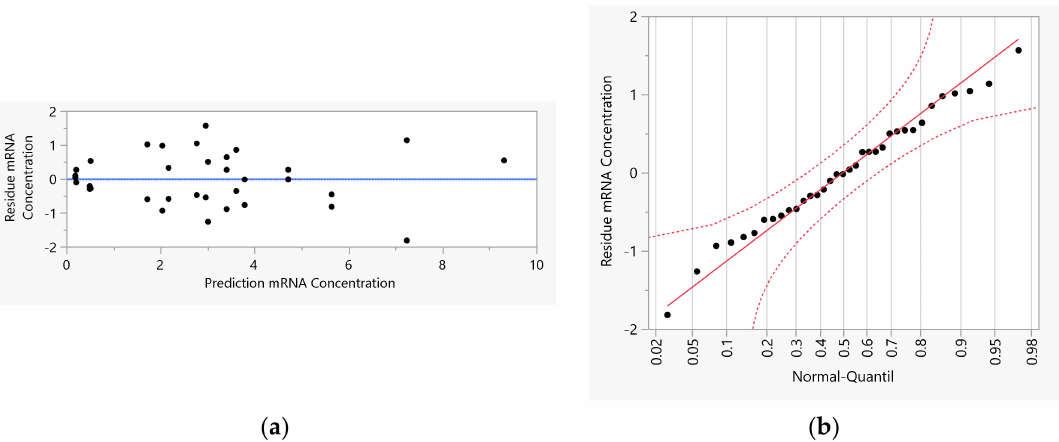
Figure 15. Visualization of the residuals (black dots) in an ( a ) ideal residual plot and a ( b ) normal probability diagram with marked confidence interval (red